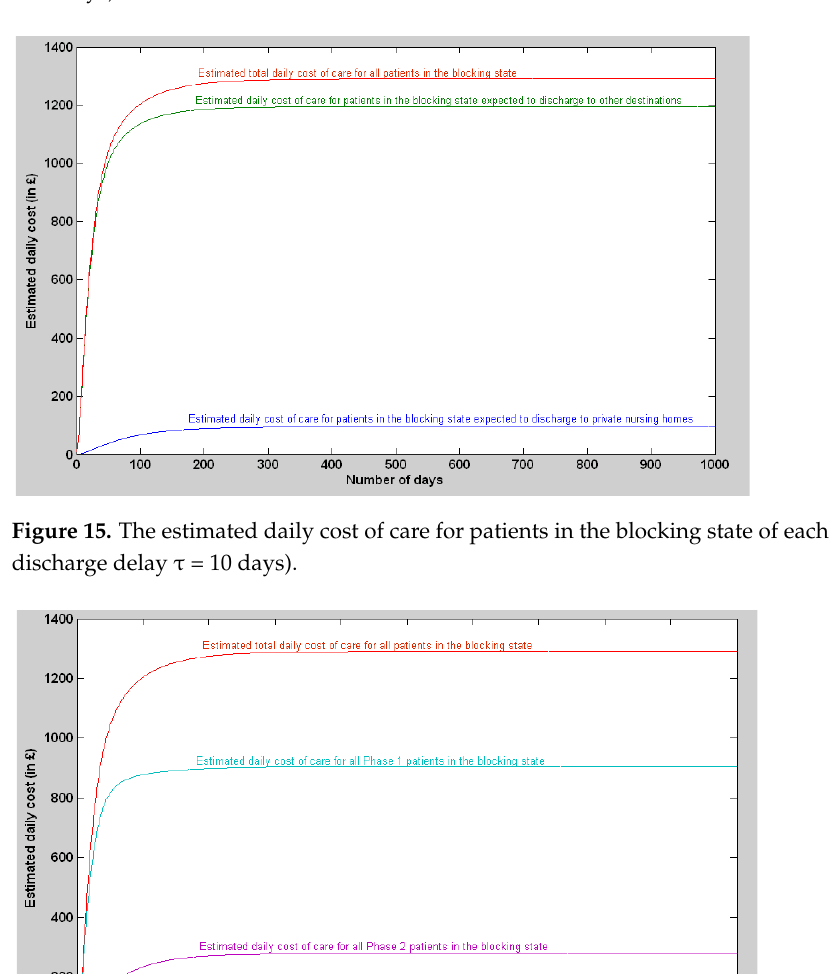
Figure 14. The estimated daily cost of care for patients in the blocking state from each phase (after 1000 days).